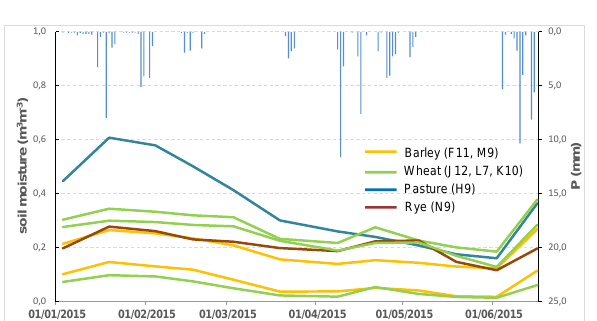
Figure 7. PWC evolution for the seven plots clustered by type of crop.